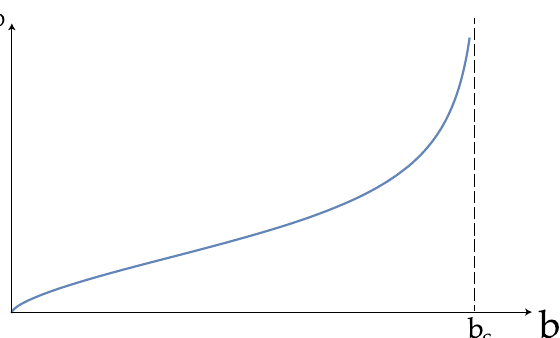
Fig. 5 Plot for the modulus of the real negative root r D as a function of theimpactparameterassociatedwiththeunboundedmotionofphotons, i.e. 0 < b < b